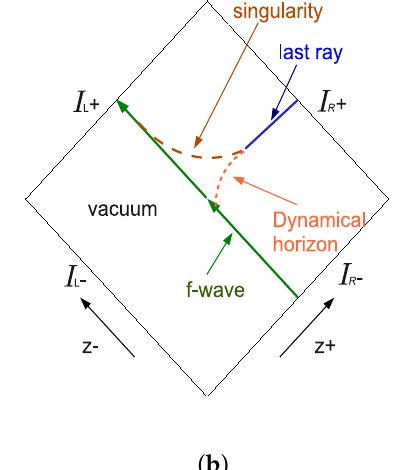
Figure 3. ( a ) Classical collapse of a narrow pulse of a massless scalar field, incident from that during the collapse a dynamical horizon (DH) is formed. It is space-like and grows in area as the collapse continues and smoothly joins on to the (null) event horizon (EH) in the distant future. ( b ) Artist’s depiction of a semi-classical Callen–Giddings–Harvey–Strominger (CGHS) black hole that was analyzed in detail in [33,34]. A Delta-distribution pulse of a scalar field from black hole in the classical theory. In the semi-classical theory, the singularity is weakened (the metric is C 0 but not C 1 ) but persists. The dynamical horizon becomes time-like, shrinks in its ‘area’ due